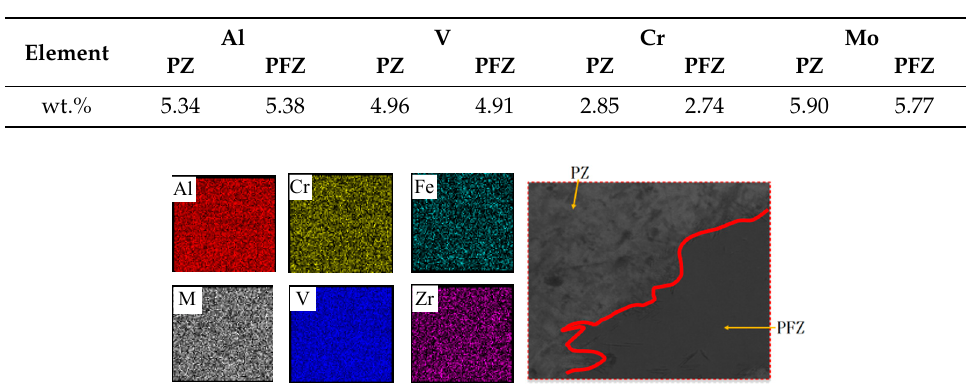
Table 1. Average weight of elements of Ti-55531 alloy in PZ and PFZ.